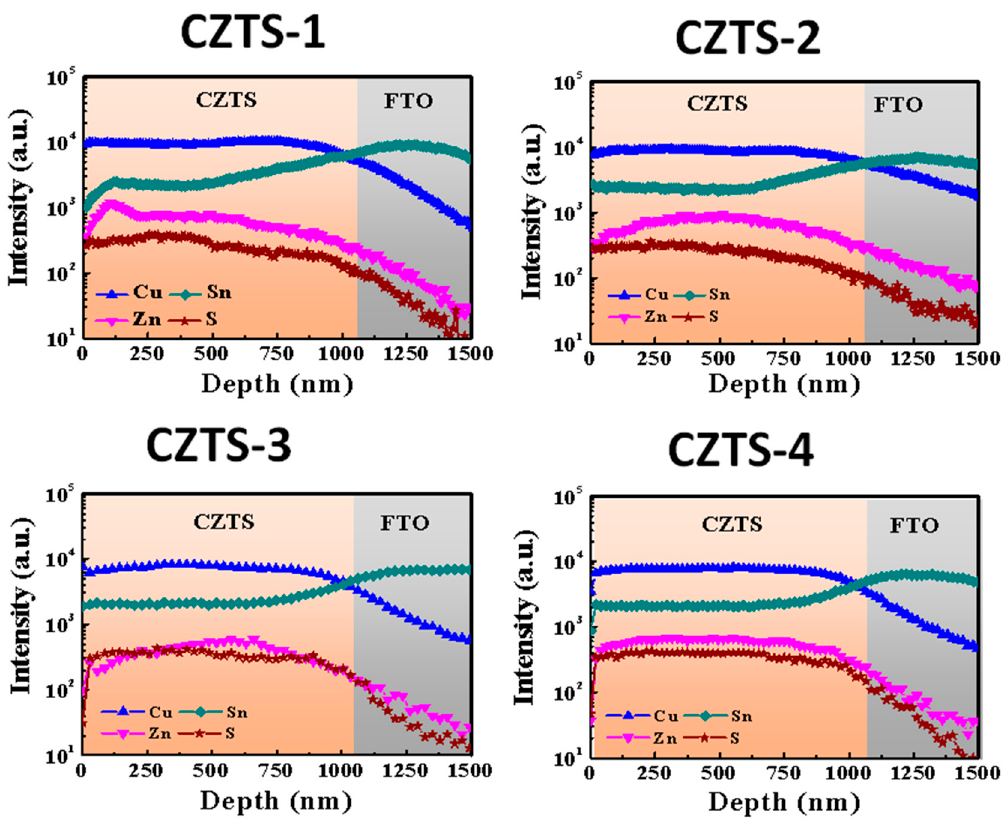
Figure 5. ( a ) Band gap, ( b ) Cu/(Zn + Sn) ratio, and band gap as a function of the number of pre-